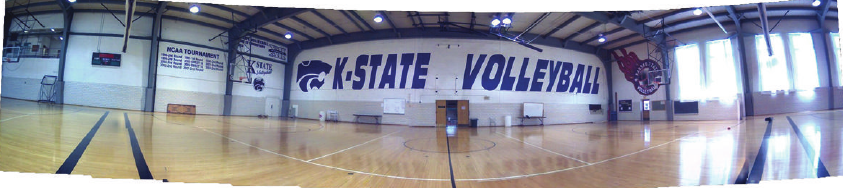
Figure 4: Image created by stitching together with some of the images used in the motion simulation. Stitched image covers 160 deg of